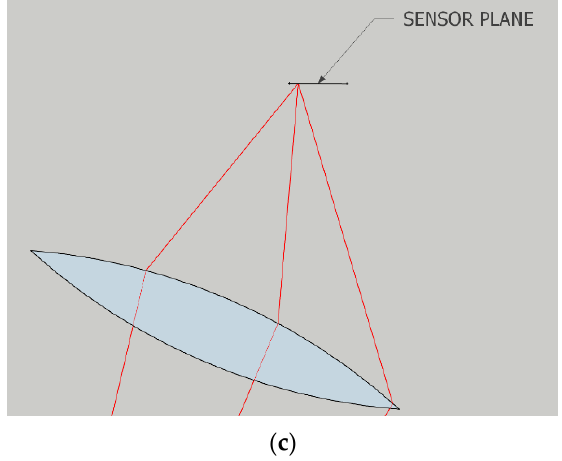
Figure 2. Zoom of the proposed measurement layout. Propagation of the THz signal when the horizontal plane is in the: ( a ) middle position, ( b ) raised vertically, and ( c ) lowered vertically.